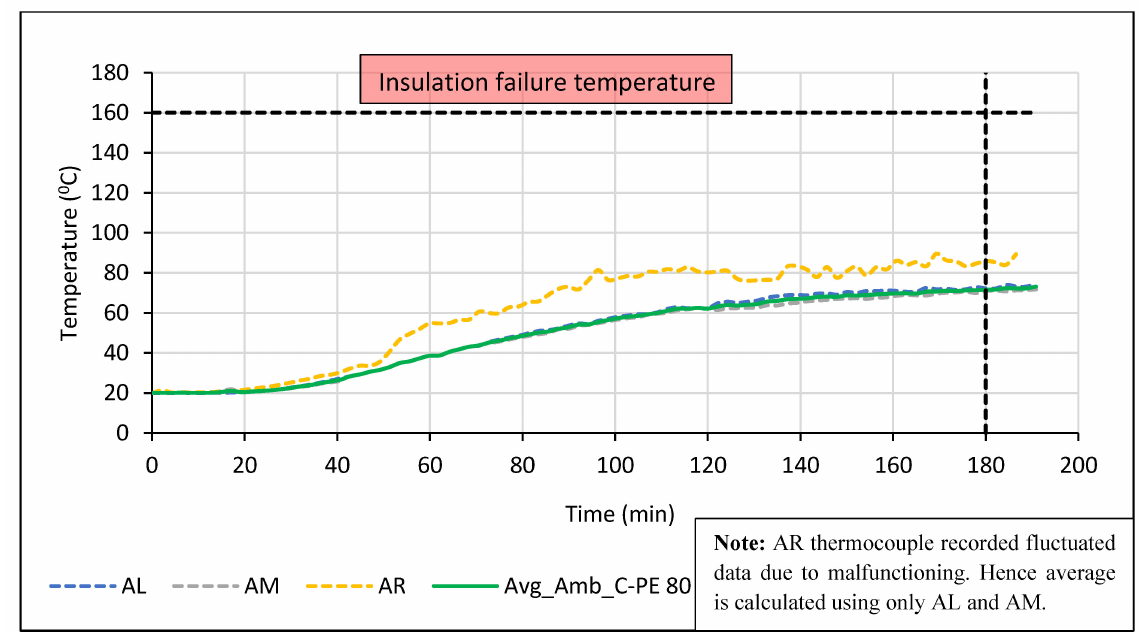
Figure 31. Ambient side surface time–temperature curves of C-PE 80 block from the building fire